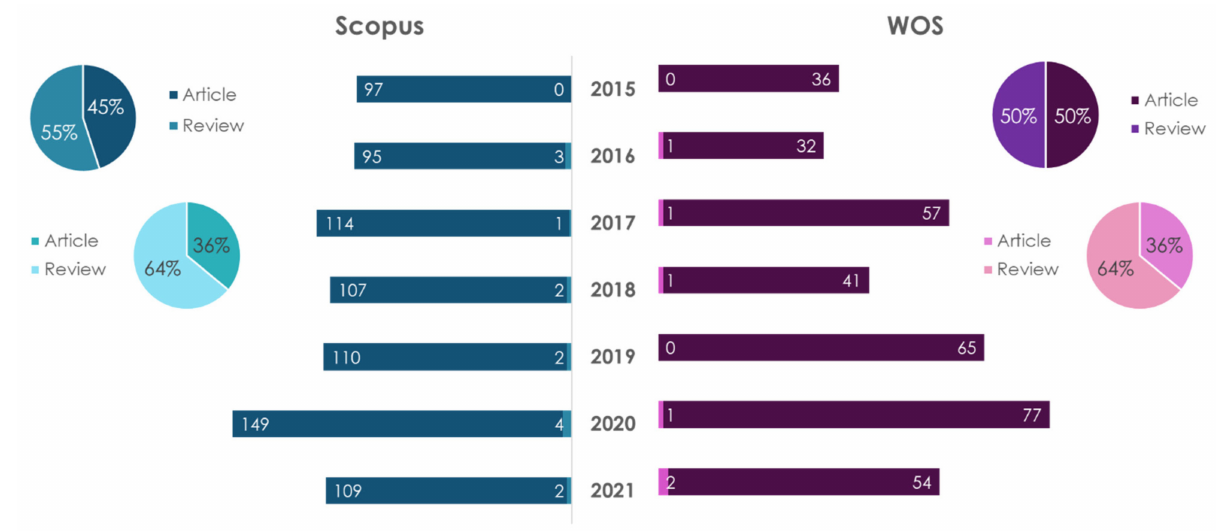
Figure 7. Statistical results of the search in Scopus/WOS databases by the keywords “epigenetics of nutrition” (dark color) and “epigenetics of nutrition and atherosclerosis” (light